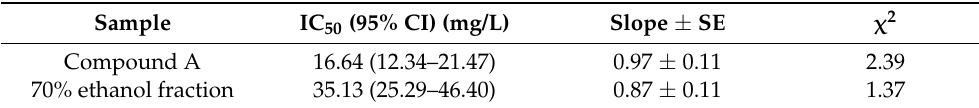
Table 1. Root growth inhibition activity of different samples against T. pratense . Data are presented Data presented are the mean of three replicates. IC 50 value was obtained using log-probit